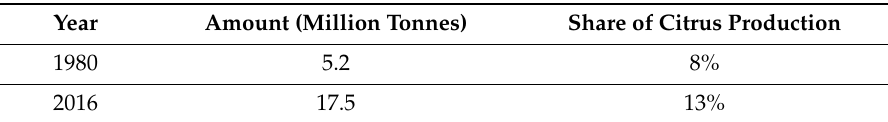
Table 1. Amounts of lemons harvested globally in 1980 and 2016 (adapted from Ref. [19], with kind